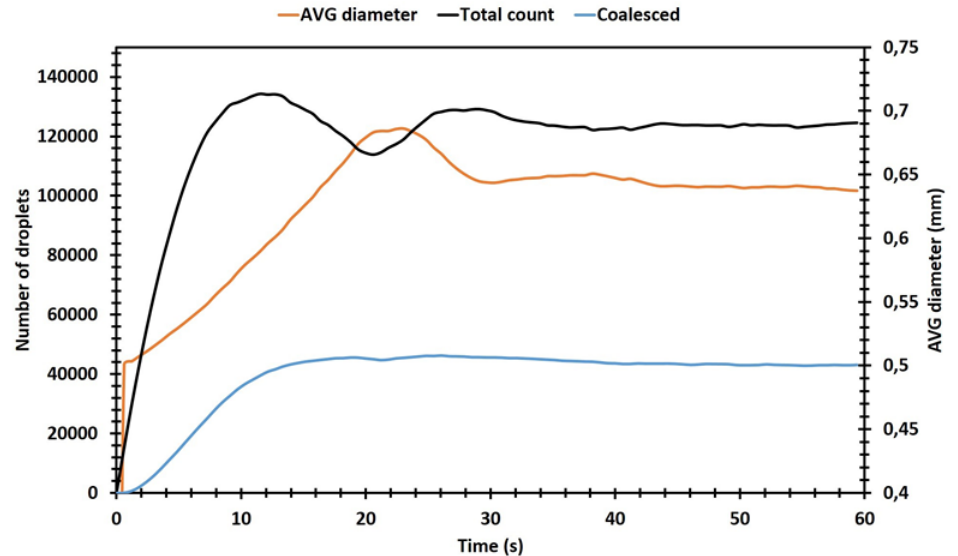
Figure 9. Droplet count and diameter development during the simulation.